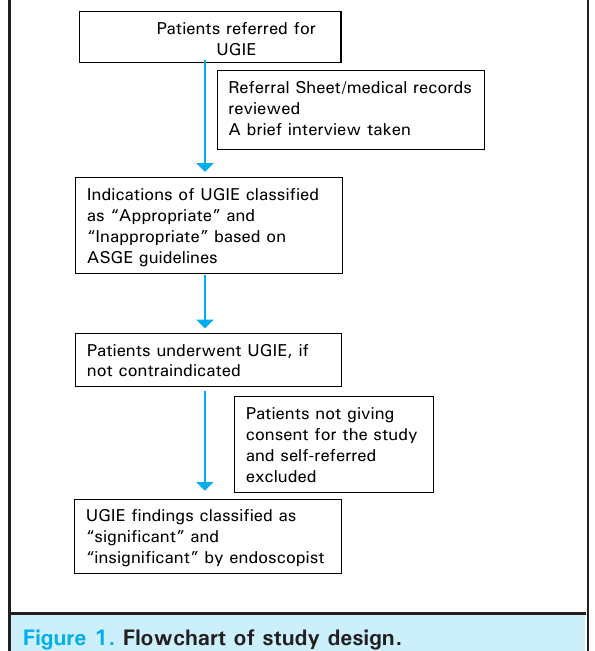
Figure 1. Flowchart of study